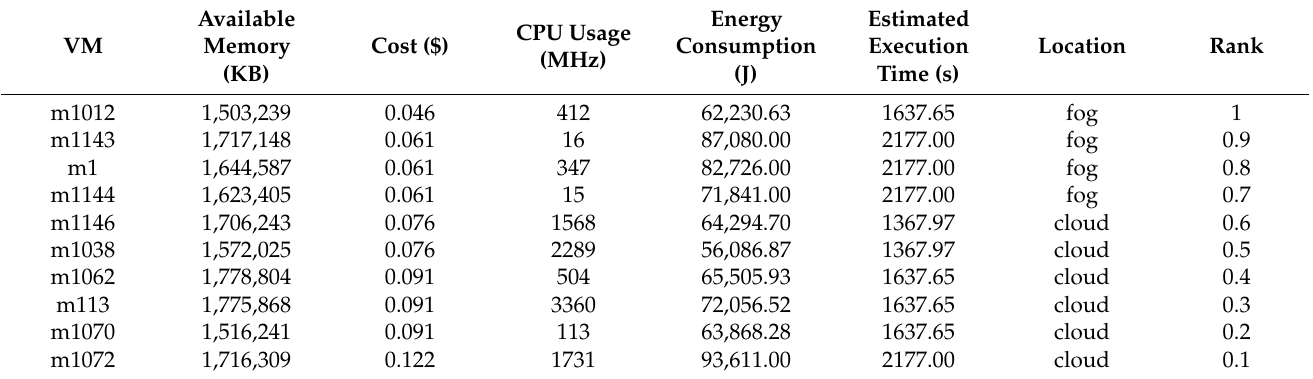
Table 13. Optimization results Task 224334 for a cost-driven and memory-driven use case with